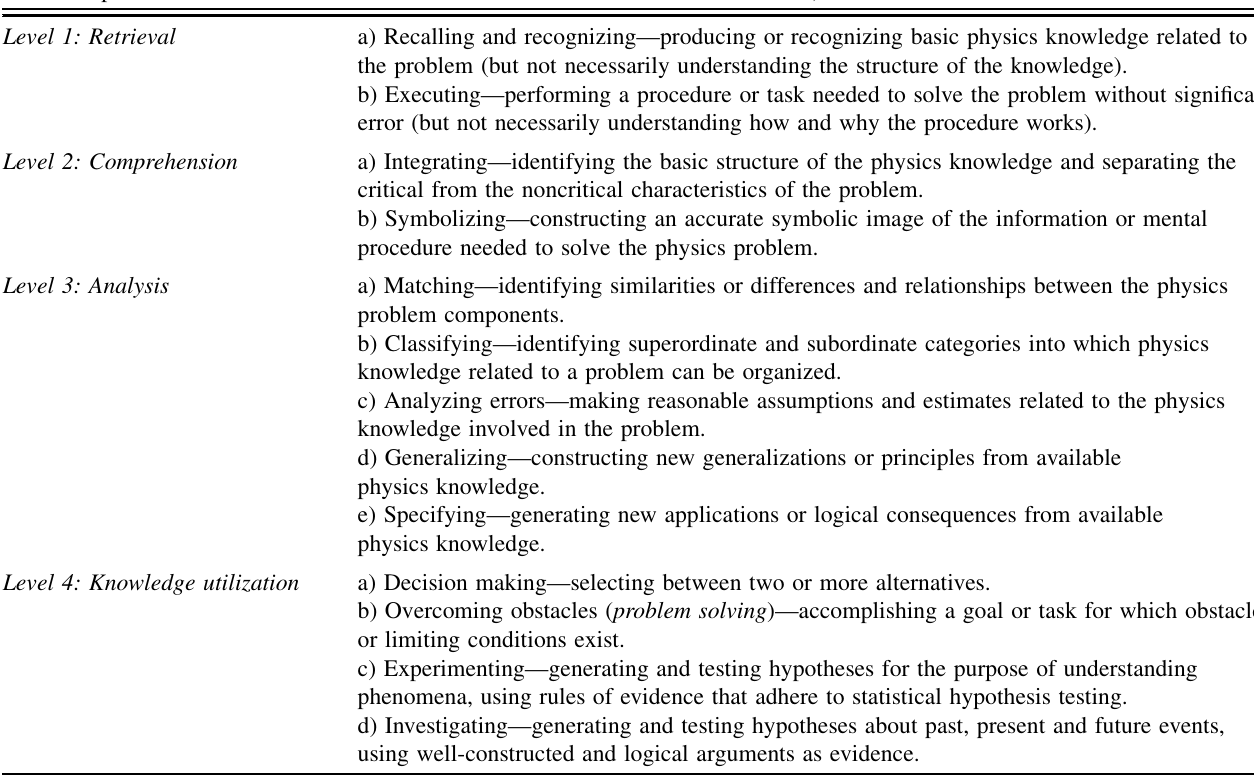
TABLE II. A summary of Marzano’s new Taxonomy of Educational Objectives [26]. All of the categories listed below apply to the two knowledge domains of information and mental procedures. (The only exception is sublevel (1b)— executing —which applies only to mental procedures and not to information as the information cannot be